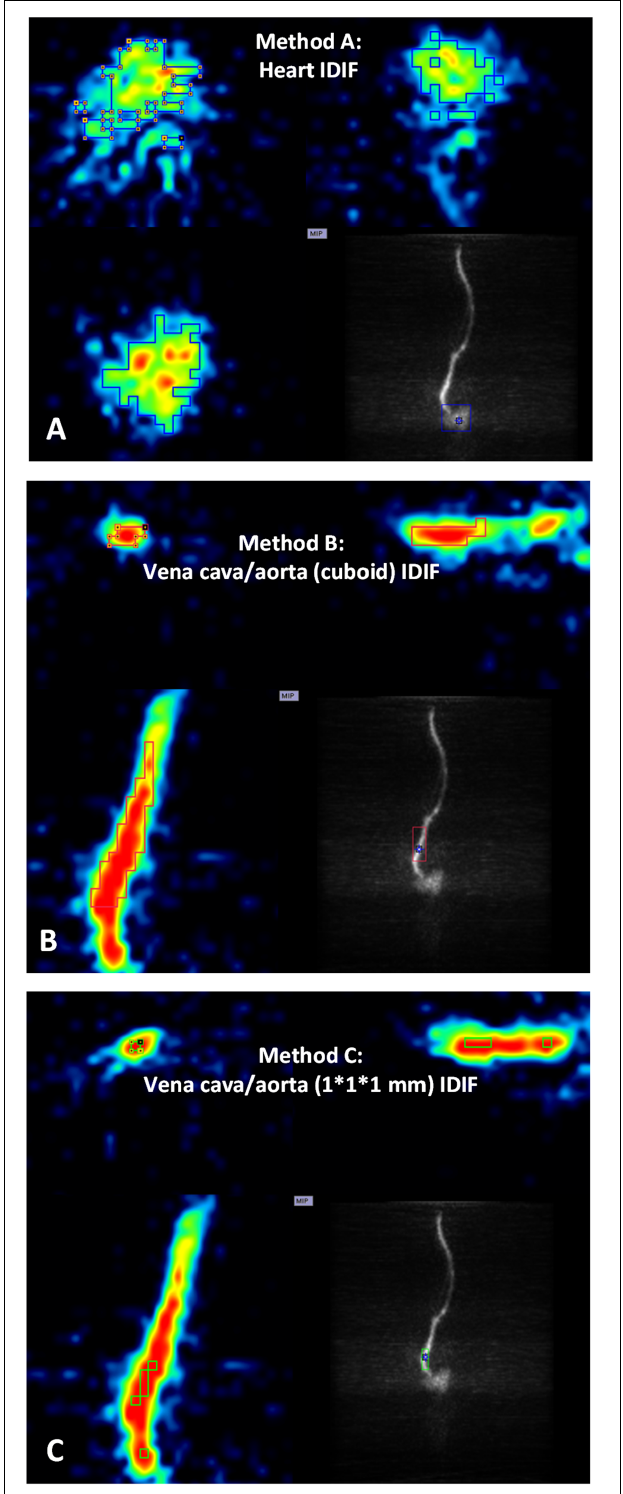
FIGURE 1 | Positron emission tomography images of heart and abdominal vena cava/aorta in a representative mouse during the first 10 s after [ 18 F]CPFPX bolus injection were used to define different volumes of interest